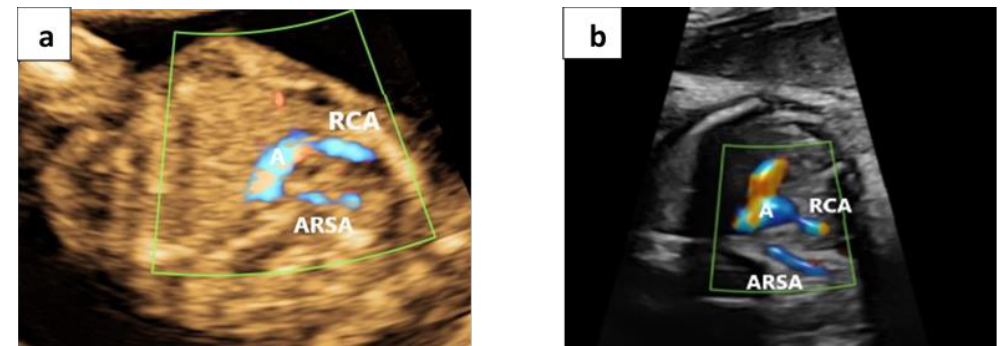
Figure 3. Negative "No ARSA" sign: The RCA emerging as a single vessel from the aortic arch with no visible bifurcation. Simultaneously, an ARSA is visualized coursing behind the trachea towards the right arm ( a ) at 14.2 weeks and ( b ) at 32.5 weeks. RCA, Right carotid artery; ARSA, Aberrant right subclavian artery. A, Aortic arch.